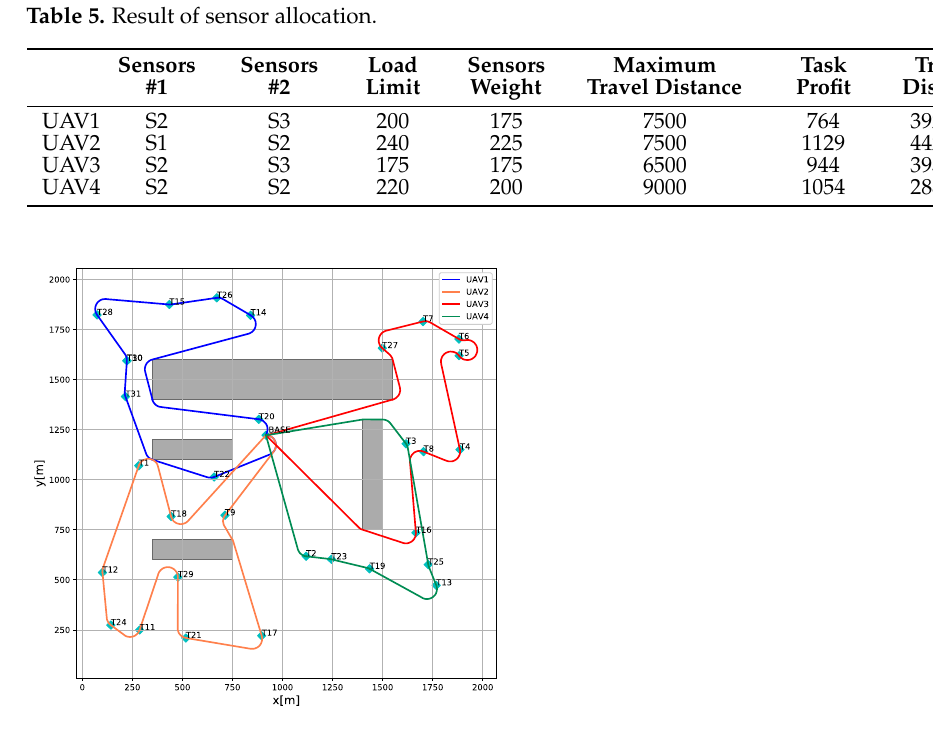
Figure 7. The task execution paths of the heterogeneous unmanned